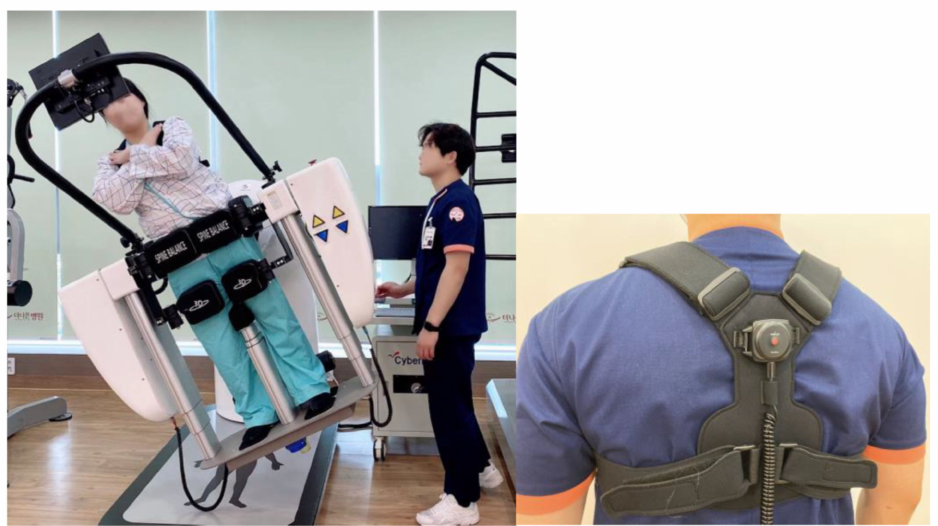
Figure 1. Spine Balance 3D. ( left ) Body tilt device, ( right ) inertia measurement unit (IMU) sensor.